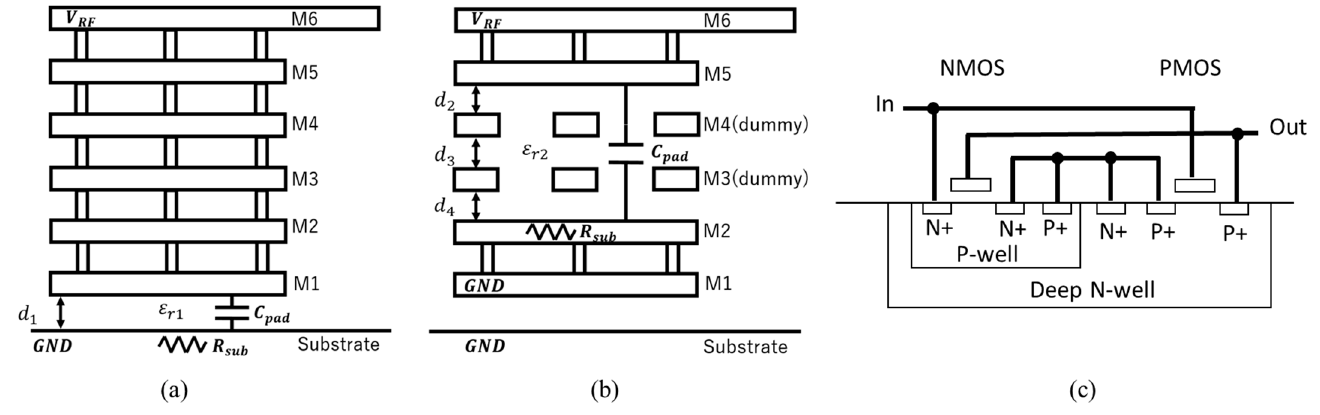
Figure 8. Cross-sectional views of the original ( a ) and revised ( b ) pads and ULPDs ( c ).